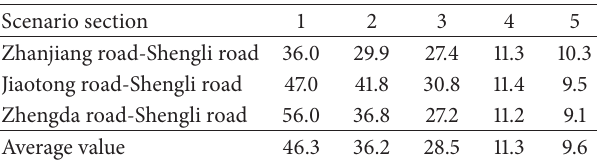
Table 2: Bus delays (s) in five scenarios along Eastbound Shengli road.